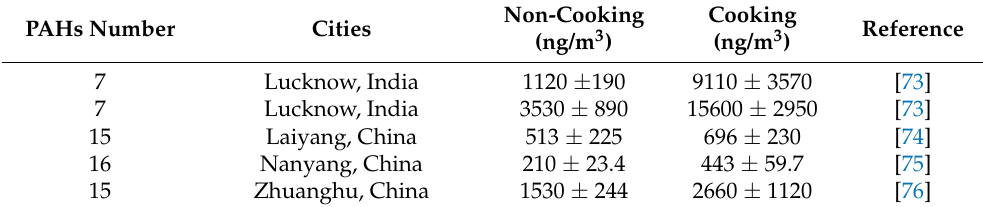
Table 4. Comparison of the concentration of PAHs in non-cooking with cooking. PAHs Number